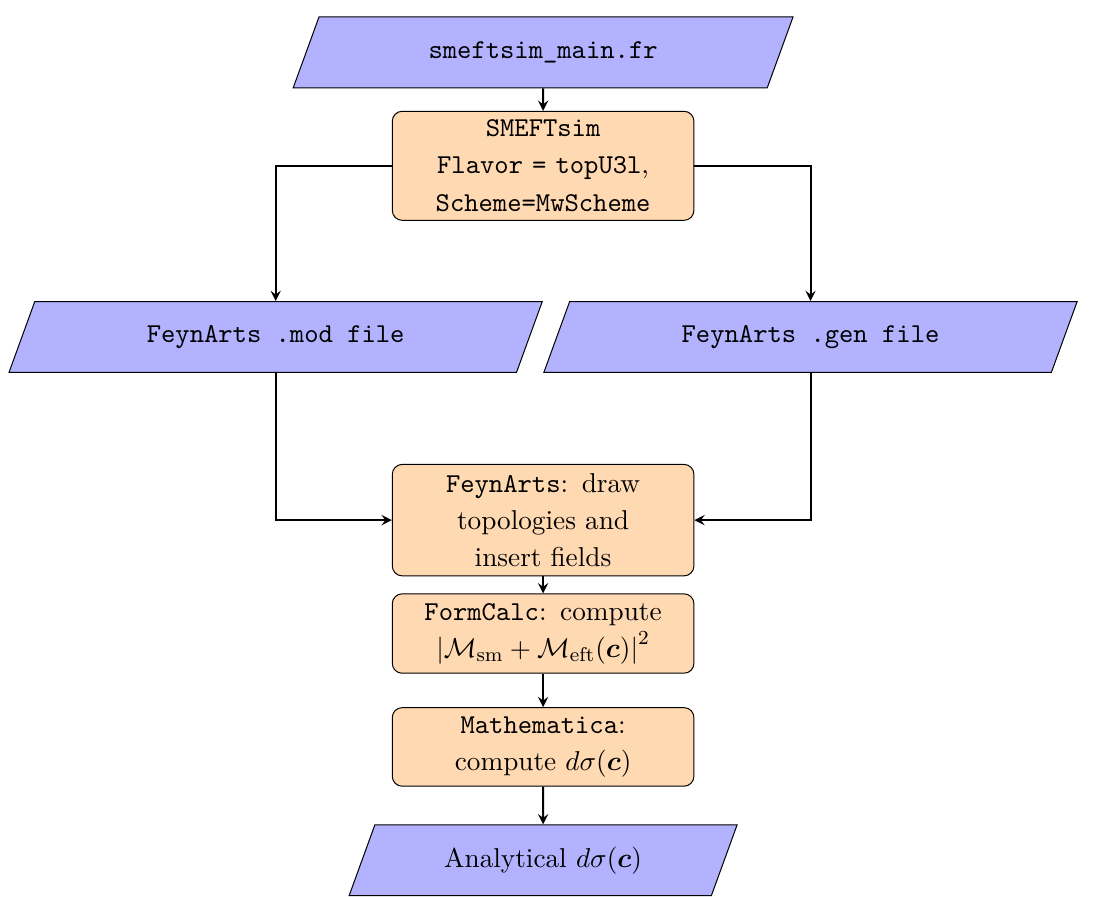
Figure 3. Flow diagram displaying the pipeline adopted to evaluate at LO analytical expressions of differential distributions in the SMEFT for the LHC processes considered. These analytical cross- sections provide access to the exact likelihood ratio to benchmark the numerical MC simulations and the performance of the ML